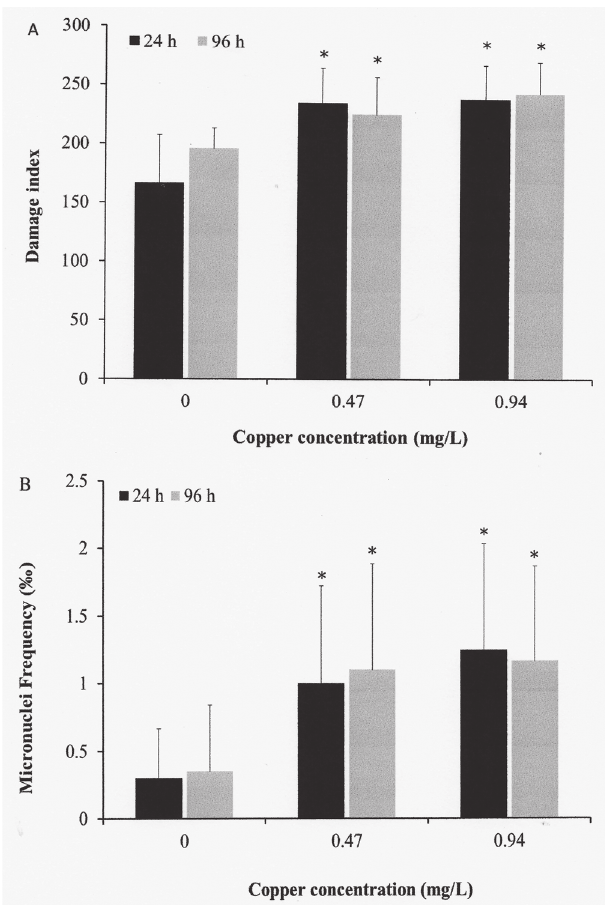
Fig. 1. DNA damage (A) and frequency of micronuclei (B) in erythrocytes of the Centropomus paralellus maintained under control condition or exposed to 0.47 and 0.94 mg/L of Cu for 24 and 96 h. *Denotes significant different mean values between control and Cu-exposed fish within the same Cu concentration and exposure time (p<0.05). No significant difference was observed between exposure times within the same Cu concentration